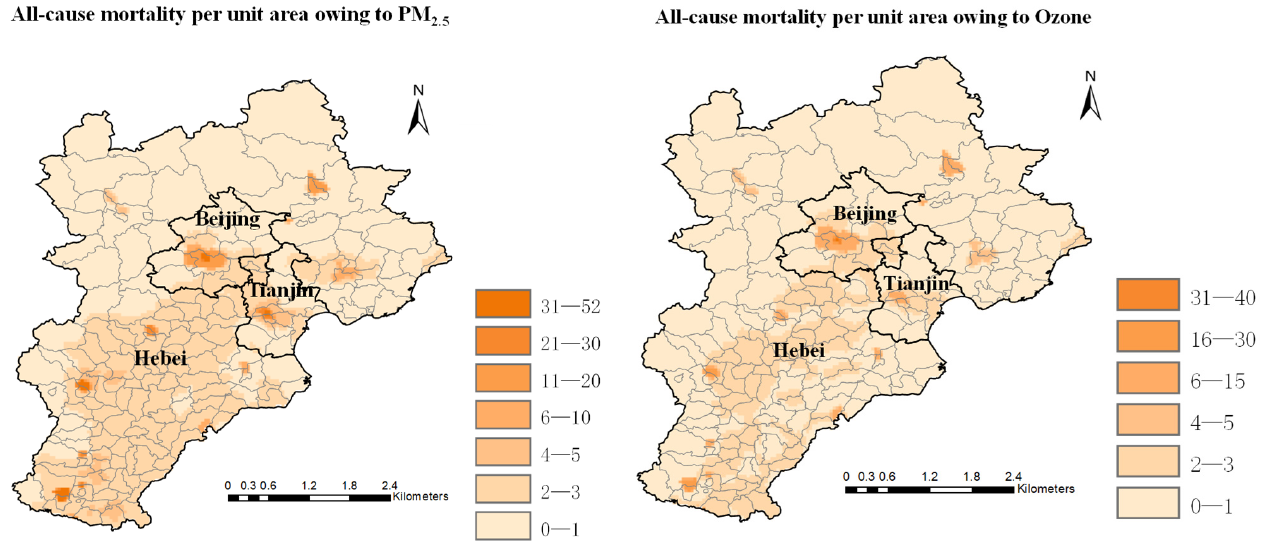
Figure 7. All-cause mortality per unit area owing to exposure to PM 2.5 ( left ) and ozone ( right ) in 2018 in the Beijing–Tianjin–Hebei region.